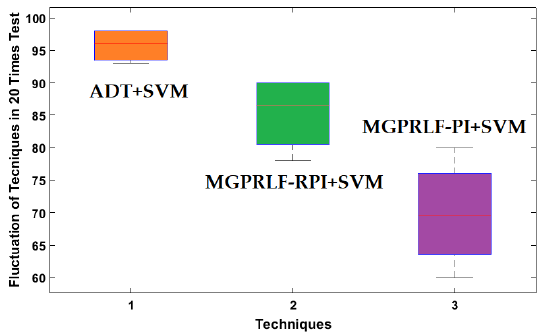
Figure 12. The average boxplots of crack identification fluctuation (NR, RF, IF, and OF) of the ADT+SVM, MGPRLF-RPI+SVM, and MGPRLF-PI+SVM techniques to test the reliability and robust- ness with 20 tests.